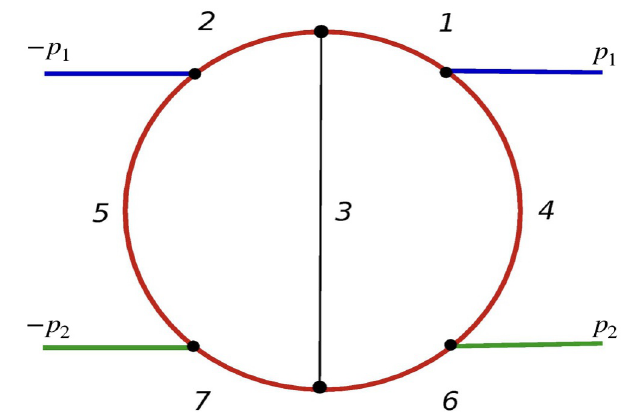
Figure 2 . The auxiliary diagram for two-loop triangle diagrams in H ( q ) → Z ( p 1 ) Z ∗ ( p 2 ) decay at O ( αα s ) . The masses of propagators are encoded in the colours of the propagators; massless(light black), m t (red), m Z (blue), m Z ∗